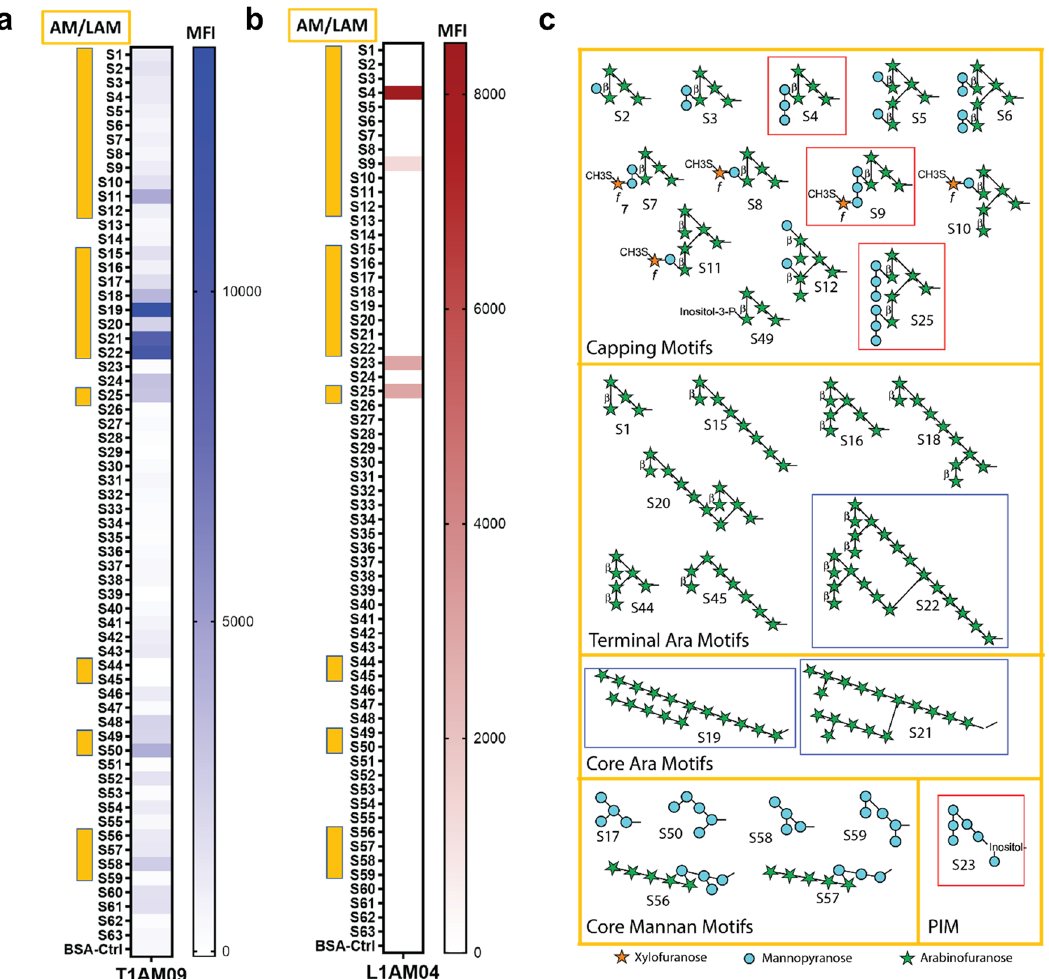
Fig. 3 Reactivity of mAbs T1AM09 and L1AM04 to mycobacterial envelope glycan epitopes. Median Fluorescence Intensity (MFI) of a T1AM09 (5 µ g/mL), and b L1AM04 (5 µ g/mL) binding 63 mycobacterial oligosaccharide fragments. Arabinomannan/lipoarabinomannan (AM/LAM) speci fi c fragments (S#1 – 12, 15 – 22, 25, 44, 45, 49, 50, 56 – 59) are marked by the yellow side bar. Six other glycans on the array are: α -glucan (S#13, 14, 24, 46, 48, 52), trehalose mycolates and lipooligosachharides (LOSs; S#38, 39, 54, 55), phenolic glycolipids (PGLs; S#26 – 37, 40 – 43, 50, 53), phosphatidyl-myo-inositol mannosides (PIMs, S#23) and glycopepitdolipids (GPLs; S#47, 60, 61). c AM/LAM and PIM motifs with those most strongly recognized by T1AM09 (blue) and L1AM04 (red). Each data point (S1 – S63) represents the mean from two or more replicates. All bonds are alpha unless designated in the fi gure as beta ( β ).